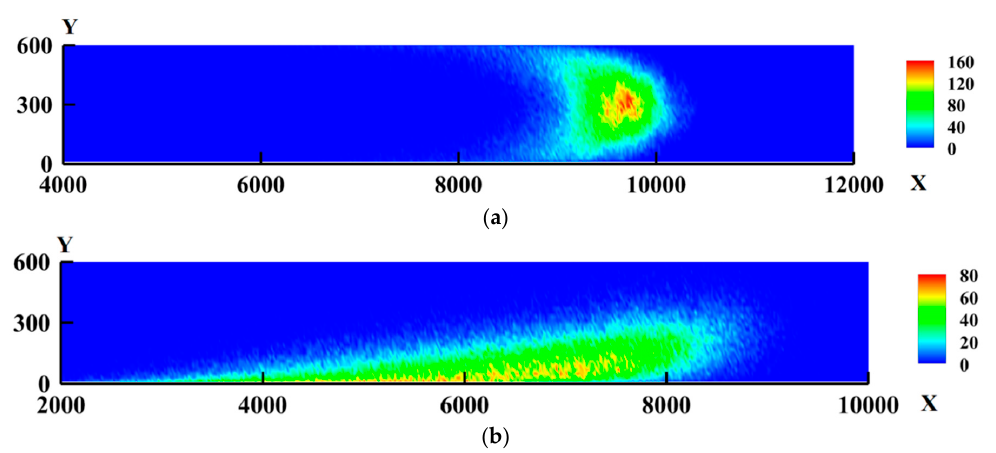
Figure 12. Contours of the location of the two puffs mixing at t = 500, corresponding to the conditions of Figure 3a. ( a ) Puff A ( Sc = 0.7, y o = 300), and ( b ) Puff B ( Sc = 0.7, y o = 15). Note that the shape of puff B is elongated in the streamwise direction and a large part of it is close to the wall. The shape of puff A looks like a jellyfish, because of the high mean velocity at the channel center. Mixing occurs at the overlap of these two puffs.